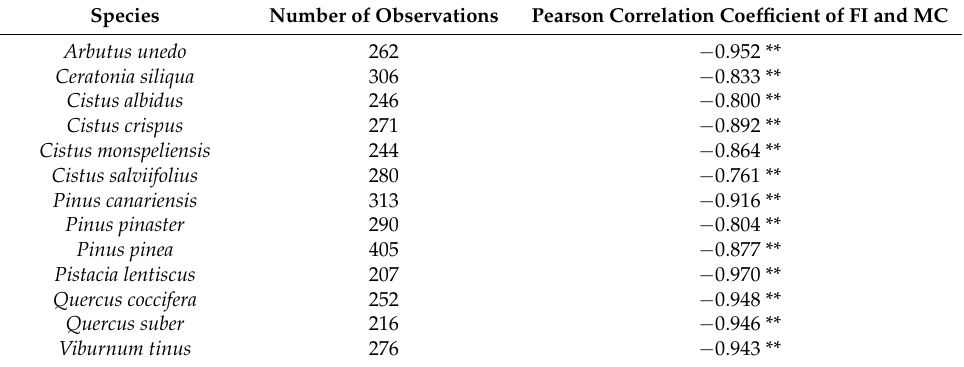
Table 5. Pearson correlation coefficient of flammability index (FI) and moisture content (MC) and number of observations per species.